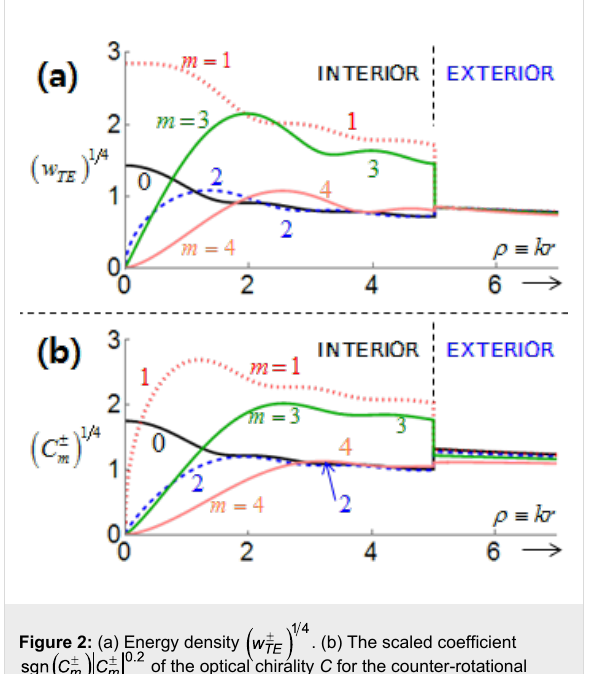
Figure 2: (a) Energy density . (b) The scaled coefficient of the optical chirality C for the counter-rotational case. Both are displayed against ρ ≡ kr ≡ ω · r / c . The data are R ρ ≡ kR ≡ 5 and m =